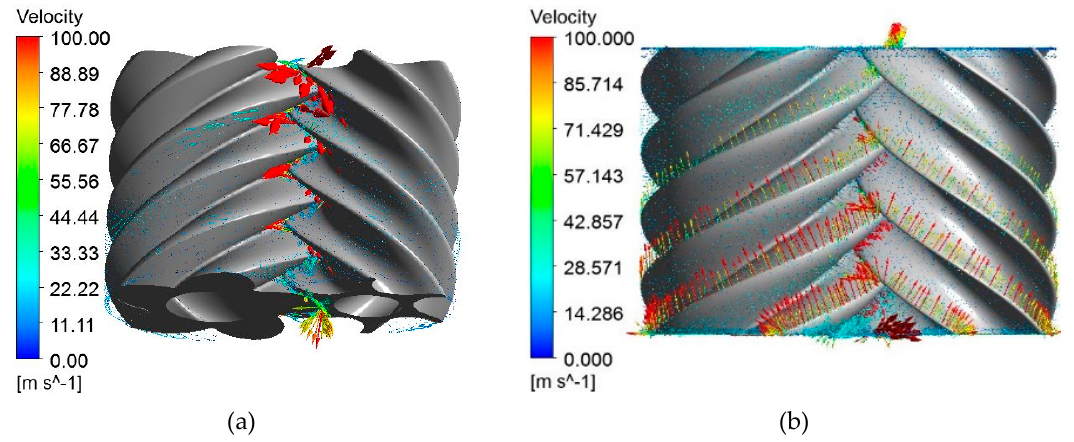
Figure 11. The leakage velocity vector: ( a ) the leakage velocity vector of the intermeshing clearance; ( b ) the leakage velocity vector of the radial clearance.